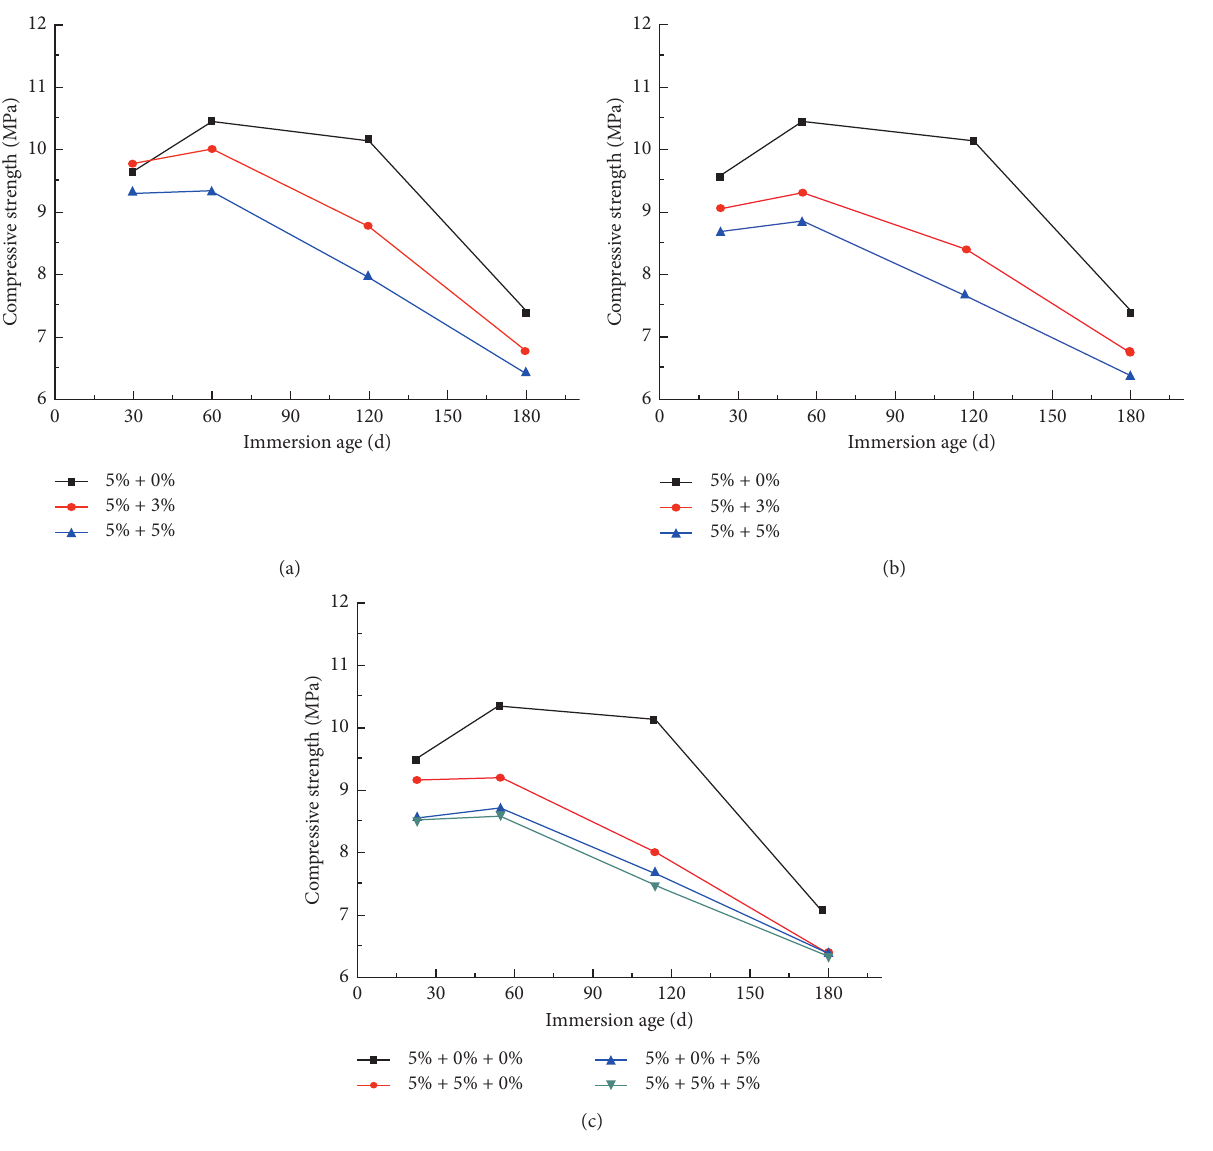
Figure 6: Effect of different ions on compressive strength of SO 42 − in CGBM. (a) Na Na 2 SO 4 +5% MgSO 4 +5% NaHCO 3 .